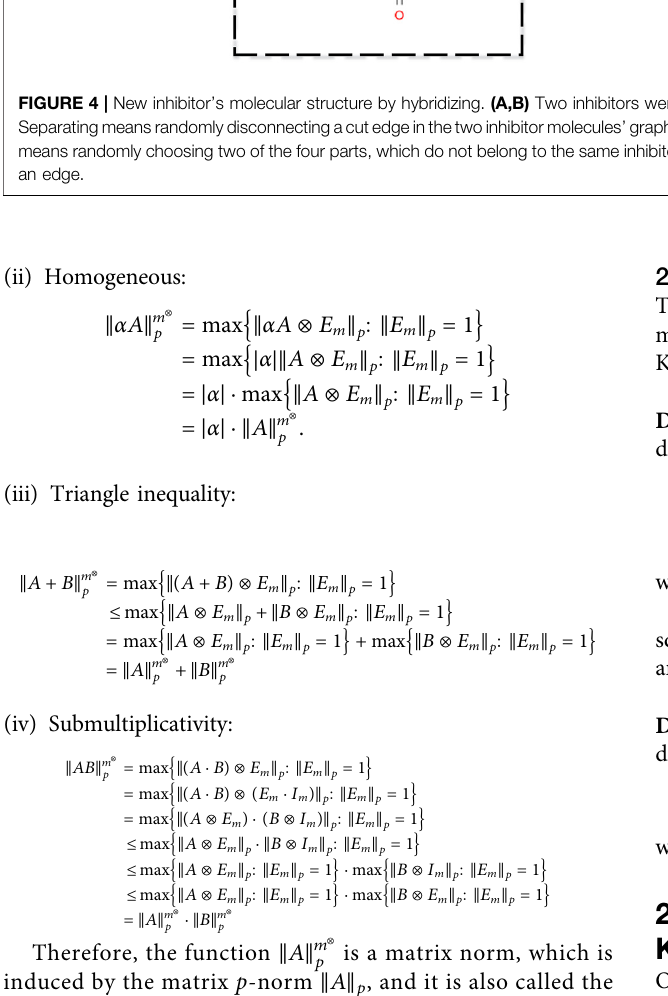
Frontiers in Pharmacology |